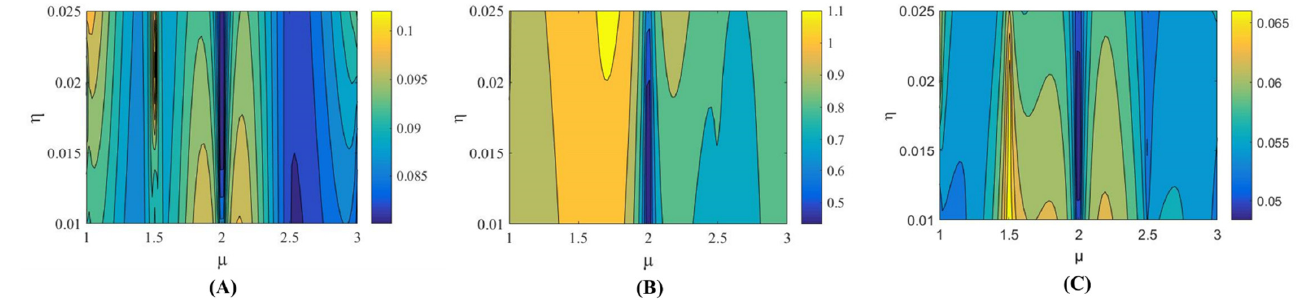
Figure 12. Contour map of Error relative to µ and η . ( A ) Taiping Island; ( B ) Tiexian Jiao; ( C ) Dongdao Island.